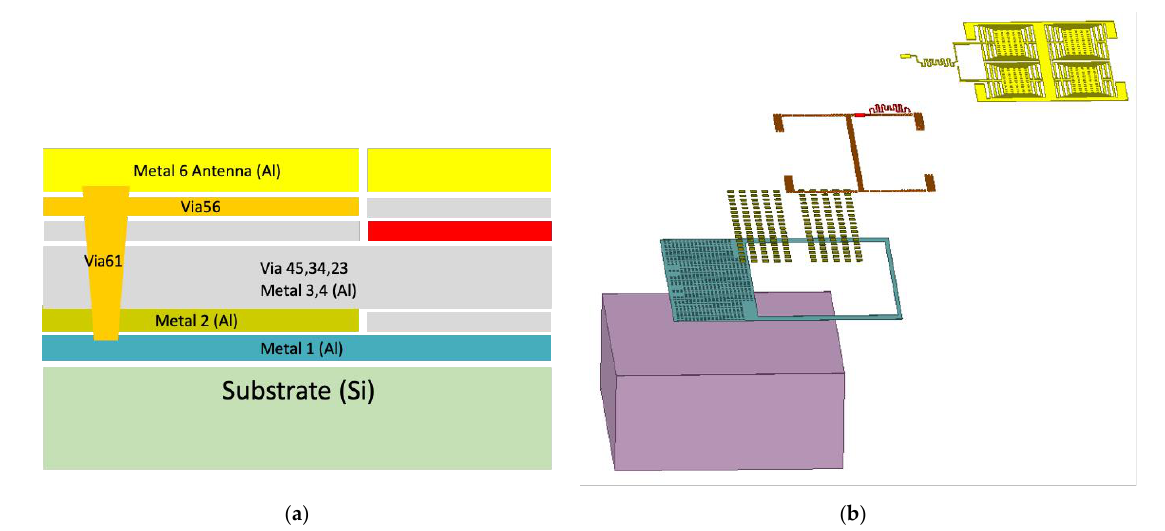
Figure 17. ( a ) Diagram of the proposed antenna model of the chip. ( b ) The process model used.